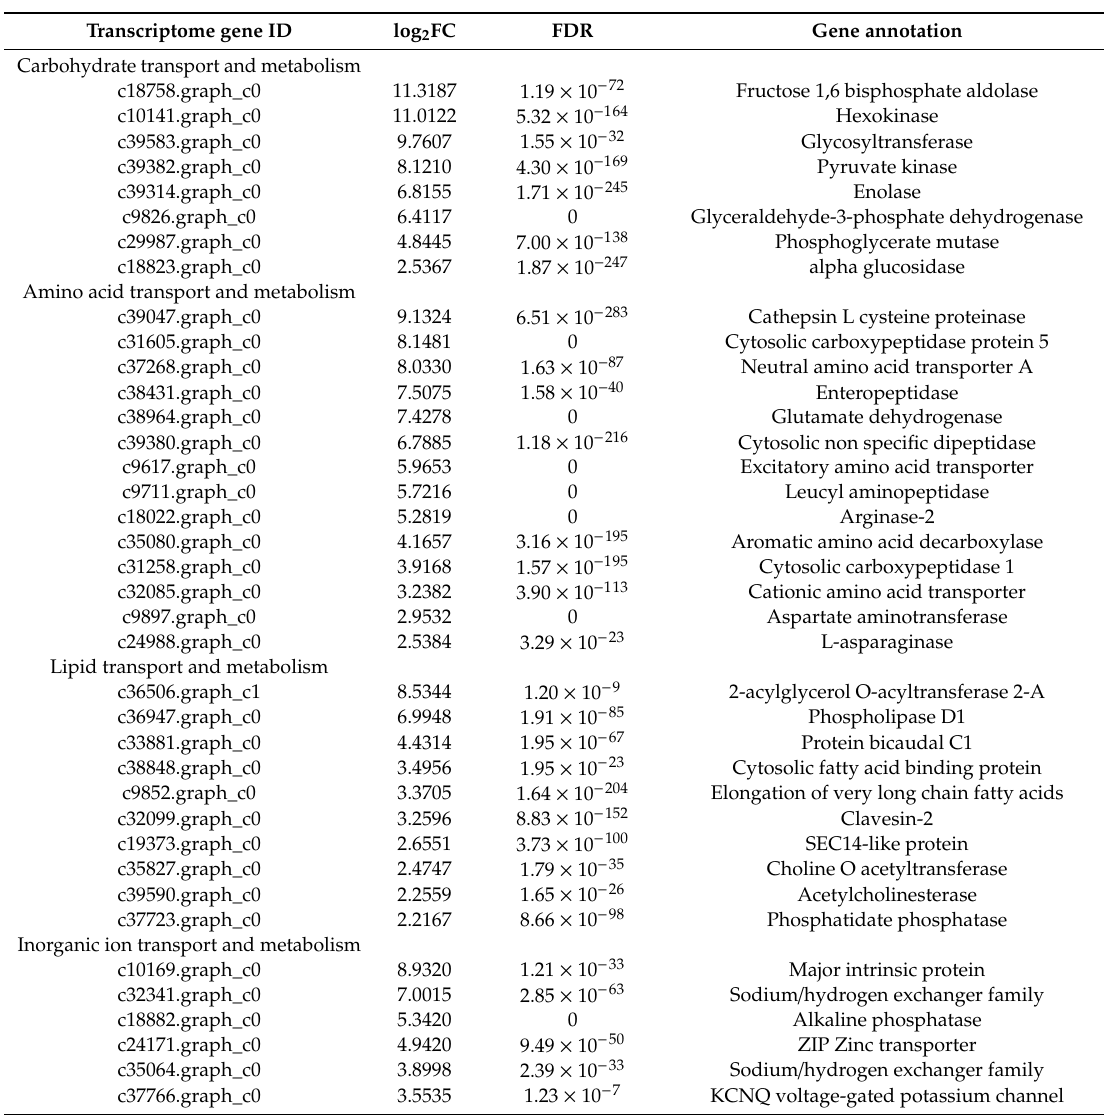
(Table S5a) identified as being involved in the transport and metabolism of nutritive materials, including carbohydrate (72 unigenes), amino acid (46 unigenes), inorganic ion (44 unigenes), lipid (38 unigenes), and nucleotide (30 unigenes). Among significantly upregulated genes of interest, those DEGs related with the glycolysis / gluconeogenesis pathway, including hexokinase (HK), pyruvate kinase (PK), glyceraldehyde-3-phosphate dehydrogenase (GAPDH), enolase (ENO), fructose bisphosphate aldolase (FBA), phosphoglycerate mutase (PGM), and lactate dehydrogenase A (LDHA), were significantly upregulated with Log 2 FC values ranging from 4.85 to 11.32. In amino acid metabolism, the genes encoding cathepsin L cysteine proteinase, neutral amino acid transporter A, enteropeptidase, glutamate dehydrogenase (GDH), leucyl aminopeptidase (LAP), and arginase were highly expressed with Log 2 FC values from 5.28 to 9.13. Additionally, phospholipase D1, cytosolic fatty acid binding protein (FAB), SEC14-like protein, choline O acetyltransferase, and acetylcholinesterase were markedly upregulated with Log 2 FC values 2.26. The important upregulated DEGs in TpA versus TpM are listed in Table 4. ≥ Table 4. List of significantly upregulated unigenes associated with the transport and metabolism of nutrient substances in adult stage of T.